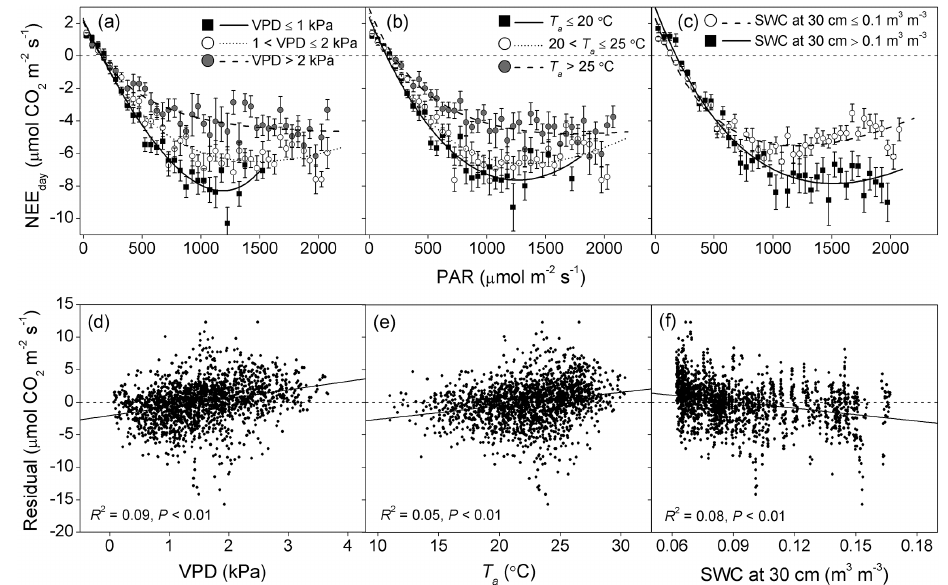
Figure 3. Daytime net ecosystem CO 2 exchange (NEE day ) as a function of incident photosynthetically active radiation (PAR) under different environmental conditions (a–c) and the relationships between residuals of the light response curve and environmental factors (d–f) . Only data from the peak growing season (June–August) were used to minimize the confounding effects of phenology. Half-hourly NEE day was bin-averaged into 50µmolphotonsm − 2 s − 1 PAR increments in (a)–(c) . Bars indicate standard errors. Light response curves were fit with Eq. (1). The horizontal dashed lines represent y =